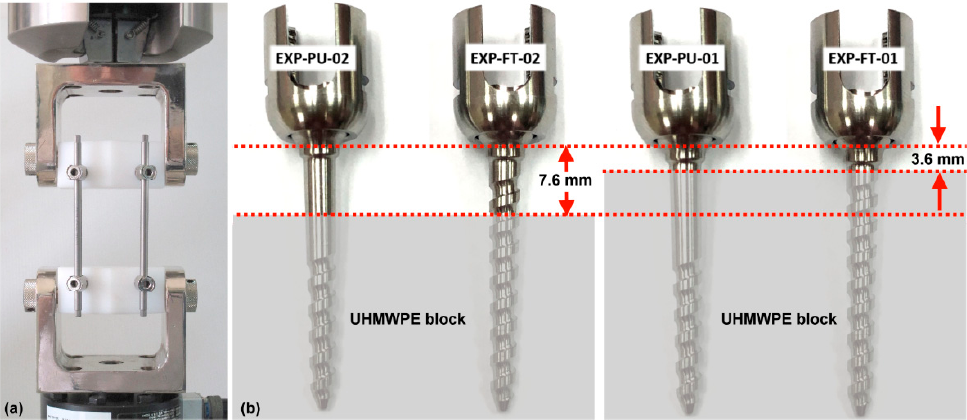
Figure 1. ( a ) American Society for Testing and Materials (ASTM) F1717 standard configuration. ( b ) Two different setups were evaluated: (i) pedicle screw fully inserted into the test block with an exposed length of 3.6 mm (EXP-FT-01 and EXP-PU-01) and (ii) pedicle screw inserted leaving 7.6 mm of the screw shaft exposed (EXP-FT-02 and EXP-PU-02).